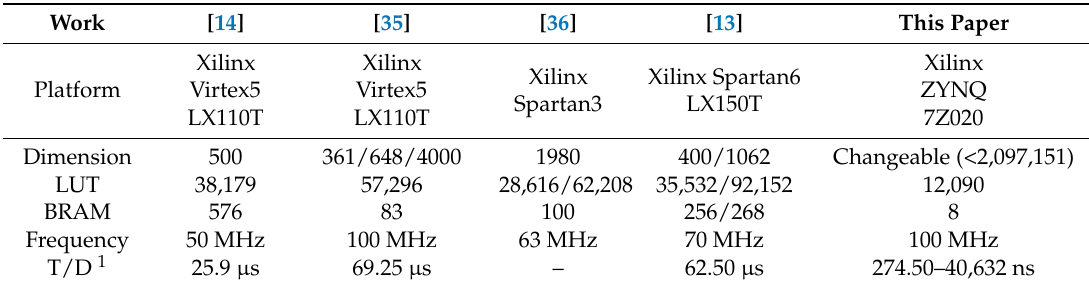
Table 3. Comparison about performance and resource utilization with previous